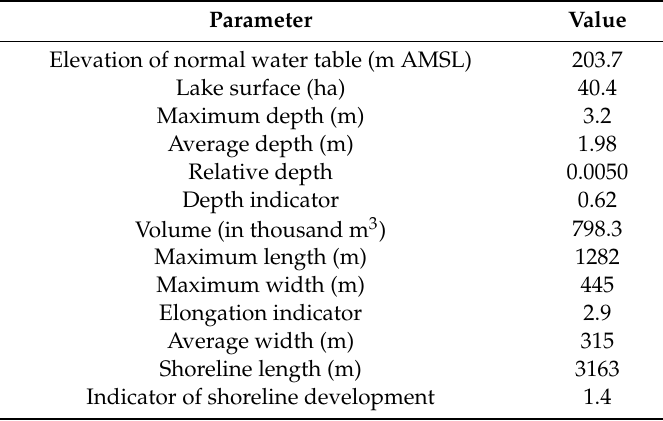
Figure 1. Location of the Karczemne Lake. Table 1. Morphometric parameters of Karczemne Lake.